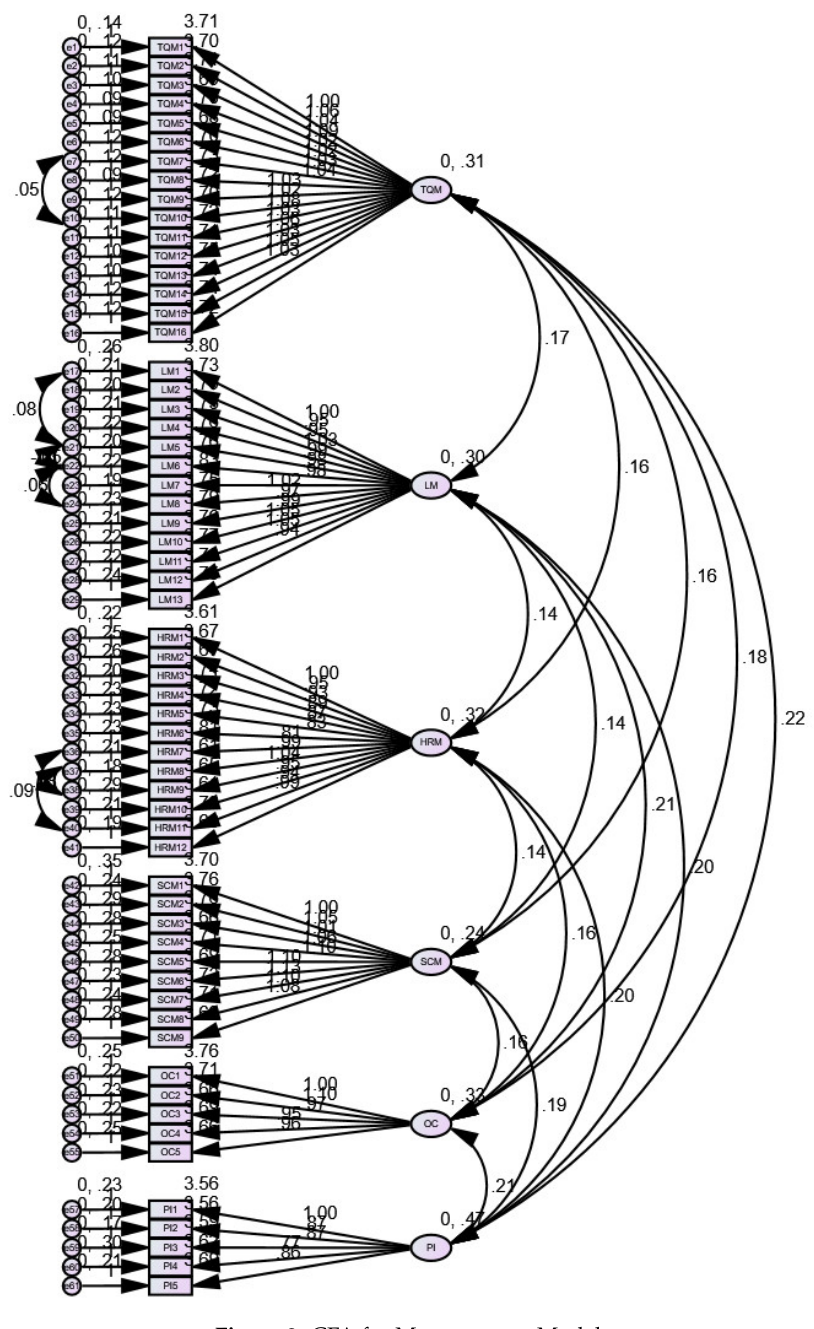
Figure 2. CFA for Measurement Model. Table 4. Discriminant